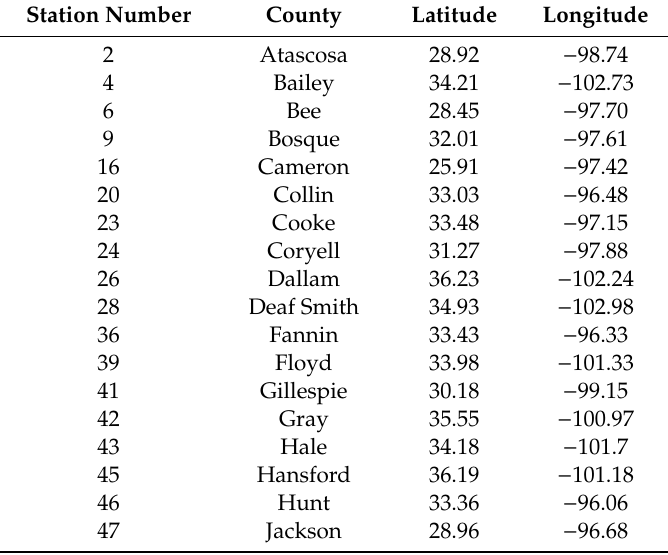
Table A1. List of counties in Texas that have rainfed sorghum yield data is